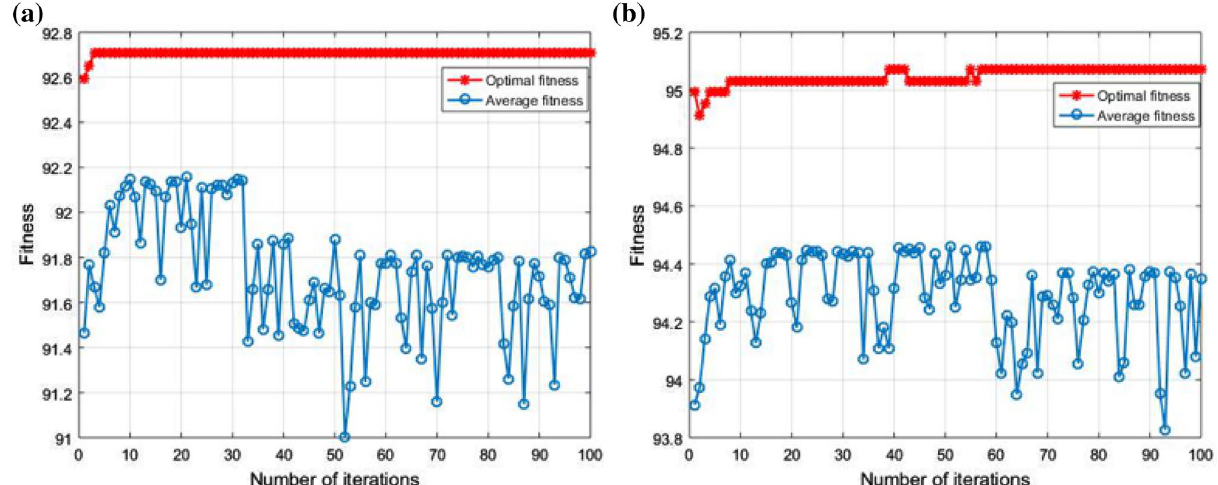
Figure 12. GA-SVM fitness curve: ( a ) fitness curve for Case 1; ( b ) fitness curve for Case 2.